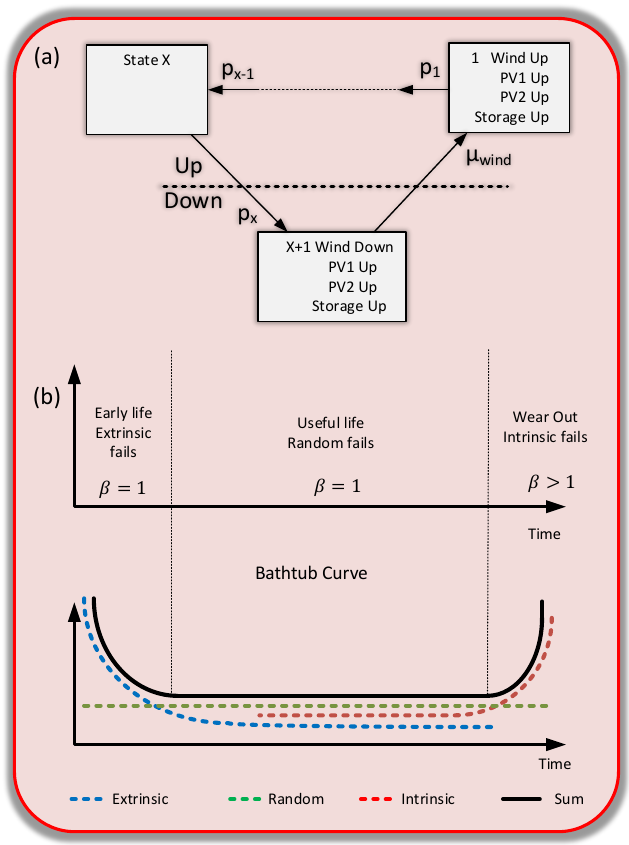
Figure 12. ( a ) Decomposing the non-exponential distributed operational states into a number of series-connected exponentially distributed states. ( b ) Bathtub curve outlining failure tendency of power converters throughout its entire operational